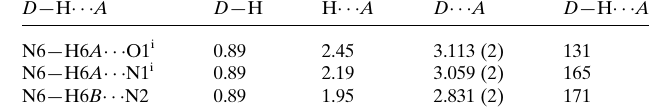
Table 2 Experimental details. Crystal data Chemical formula